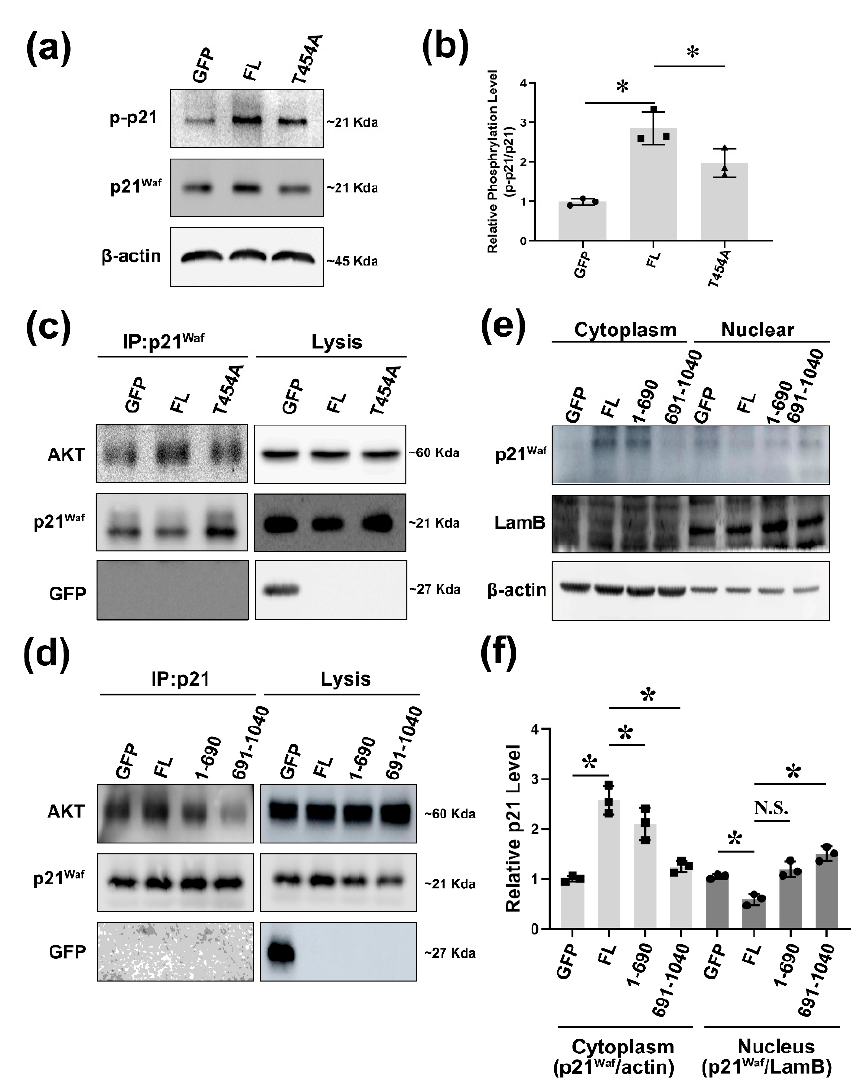
Figure 3. δ -catenin promotes the interaction between p21 and AKT, which phosphorylates p21 at Thr-145 residue. ( a ) Rv-1 cells were transfected with GFP, δ -catenin-GFP, or GFP-T454A. Cell lysates were immunoblotted with anti-p21 waf , anti-p-p21, and anti- β -actin. This experiment was repeated independently three times. ( b ) The quantitation of p-p21/p21 in ( a , c ) Immunoprecipitation with anti-p21 waf and immunoblotting with anti-AKT of lysates from Rv-1 cells transfected with the respective plasmid. ( d ) Immunoprecipitation with anti-p21 waf and immunoblotting with anti-AKT of lysates from Rv-1 cells transfected with the respective plasmid. ( e ) Rv-1 cells were transfected with respective plasmid. Nuclear and cytoplasmic p21 levels were measured by immunoblotting with anti-p21 waf , anti-LaminB1, and anti- β -actin. This experiment was repeated independently three times. ( f ) Densitometry data of p21 in ( e ) were normalized using LamB (Nucleus) or β -actin (Cytoplasm) densitometry data. All p -values were determined with unpaired Student’s t -test: *, p < 0.001.